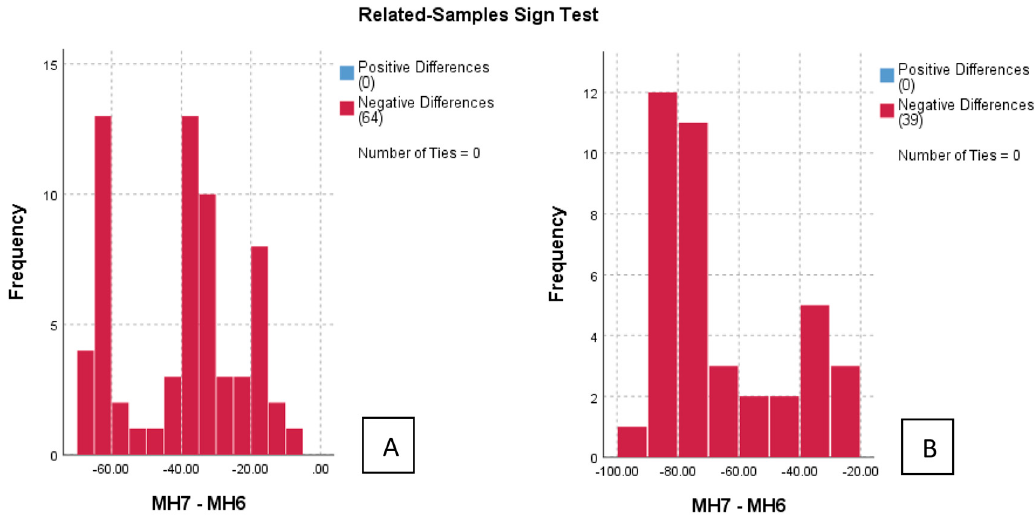
Figure 10. Related-samples sign test histogram showing the positive and negative di ff erences between manhole 7 (after the SuDS trees) and manhole 6 (before the SuDS trees) during 20 August–22 October 2018 ( A ) and 18 January–25 February 2019 ( B ). Both histograms show only negative di ff erences indicating flow level was lower downstream of the SuDS